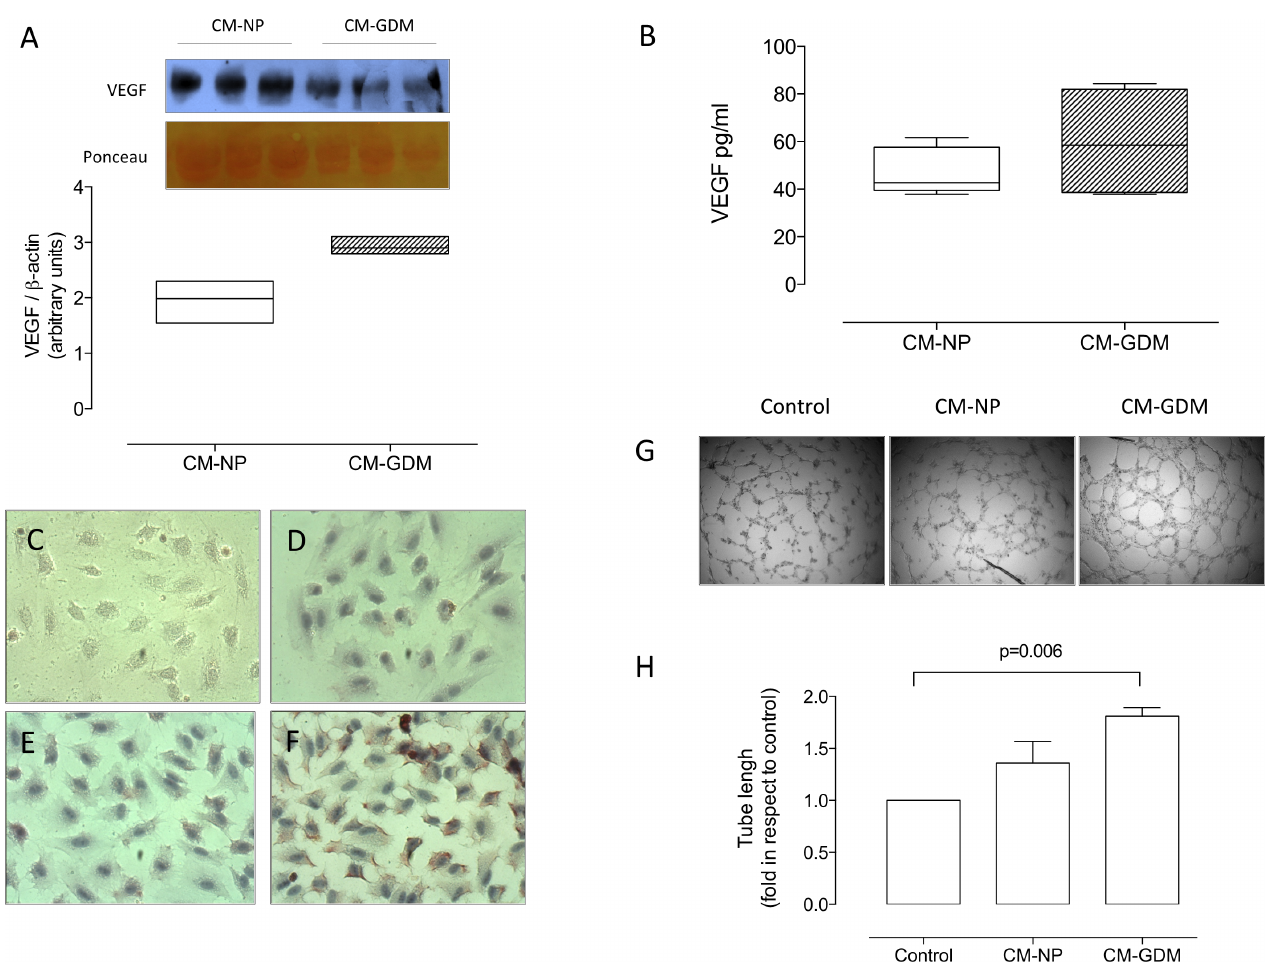
Fig 6. Characterization of conditioned medium from HUVEC isolated from GDM. A) Estimation of VEGF concentration by western blot in conditioned medium harvestedfrom HUVEC derived from normal(CM-NP, white bar) or GDM (CM-GDM, hatched bar). B) Quantificationof VEGF in conditioned medium using ELISA as in A. C) Representative images of negativecontrol (without primary antibody)in the immunocytochemistry for KDR identification in HUVEC isolatedfrom normalpregnanciesand exposed (8h) to either D) M199 (control medium), E) CM-NP or F) CM-GDM. G) Tube formation assay in HUVEC in presence(8h) of control medium (control), CM-NP or CM-GDM. H). Tube length quantification in the tube formation assay. Magnification 40X. All Figs represent n = 3 in each group. Significant differences are indicatedwith respectiveP